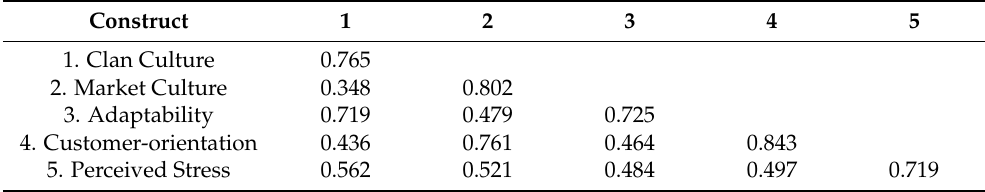
Table 9. The Results of Discriminant Validity.